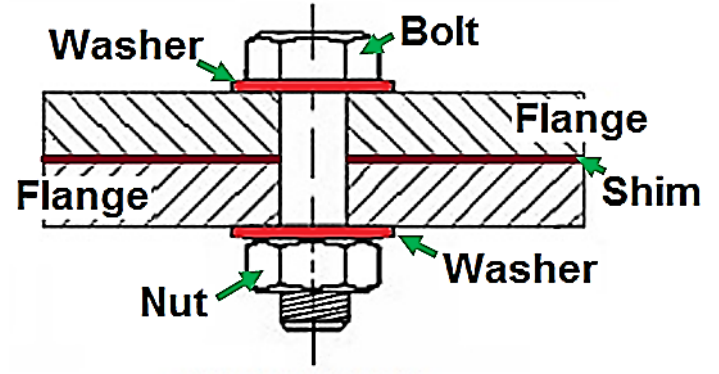
Figure 7. Schematic of a bolted flange connection.